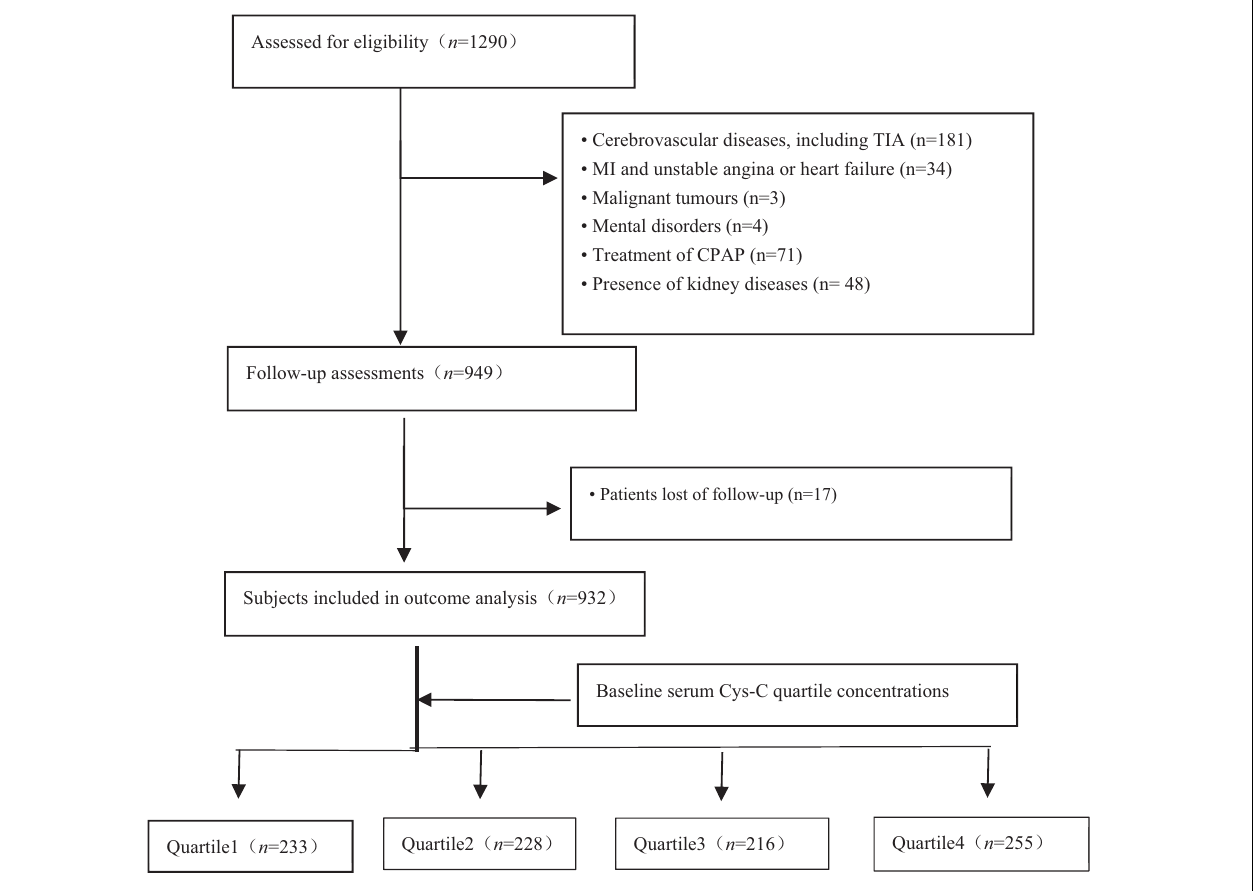
FIGURE 1 | Study flowchart. MI: myocardial infarction; CPAP: continuous positive airway